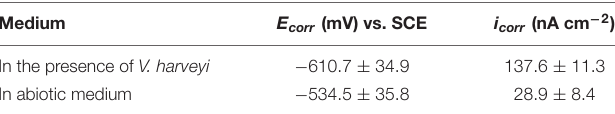
TABLE 1 | Electrochemical parameters obtained from potentiodynamic polarization curves of AA2024 after 7-day immersion. Medium